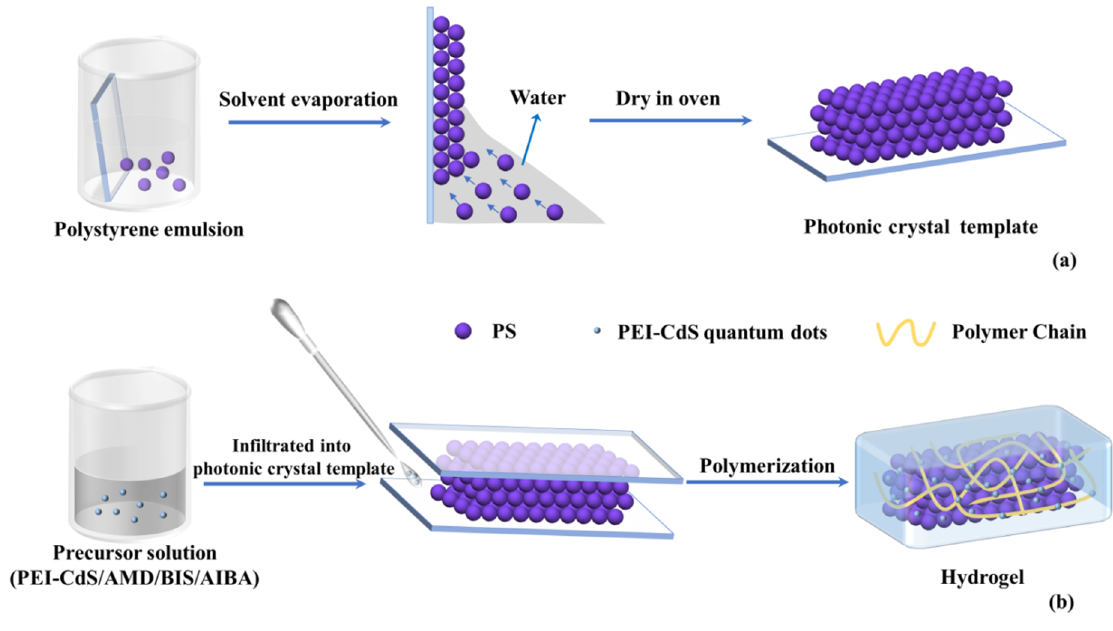
Scheme 1. Schematic diagram of the PEI-CdS QD-embedded photonic crystal hydrogel preparation process. ( a ) Prepara- tion of photonic crystal template, ( b ) preparation of QD-embedded photonic crystal hydrogel.